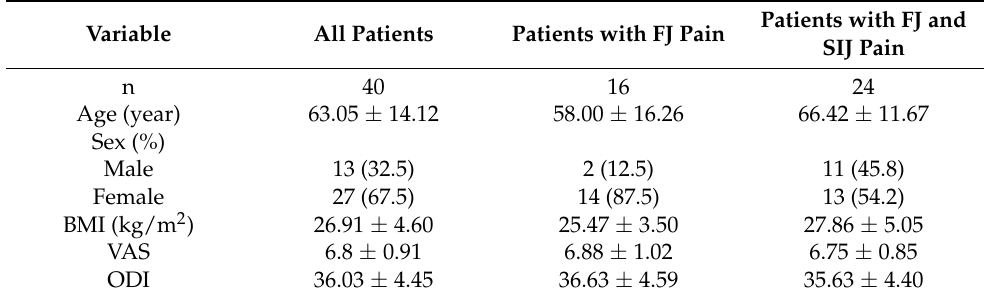
Table 1. Major characteristics of the patients at baseline. Variable All Patients Patients with FJ Pain